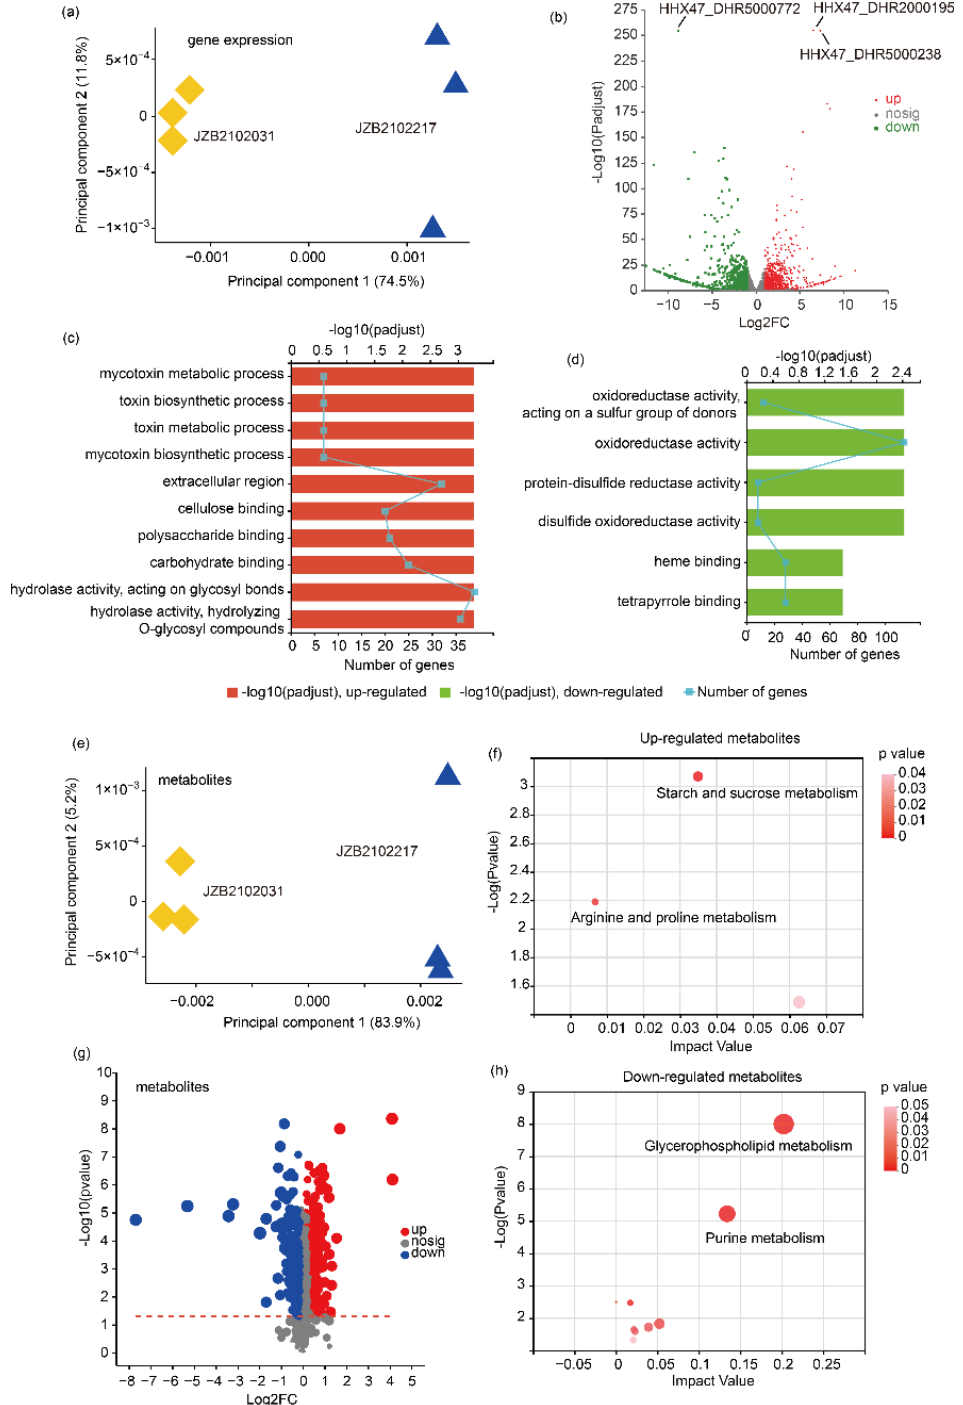
Figure 1. The transcriptional and metabolic profiling of H-type L. edodes strain JZB2102217 and L-type strain JZB2102031. ( a ) Principal component analysis (PCA) of transcriptome data of both strains; ( b ) volcano plot showing the up- and down-regulated genes; ( c , d ) the top 10 KEGG-enriched items of up- and down-regulated genes (padjust < 0.05), respectively; ( e ) PCA of the metabolome data of both strains; ( f , h ) the KEGG topology analysis of the up- and down-regulated metabolites, respectively; ( g ) volcano plot showing the up- and down-regulated metabolites (FDR < 0.05, VIP from OPLS- DA ≥ 1, |log2FC| > 1 ).